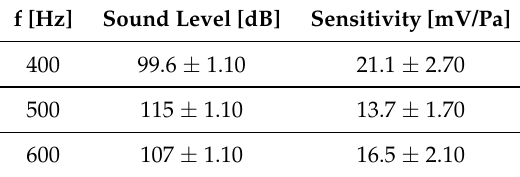
Figure 26. A picture and a schematic of the setup for the sound level reference measurement. Table 5. The sound levels and dynamic strain sensitivities for an EpoCore GMR grating sensor foil at 400, 500 and 600